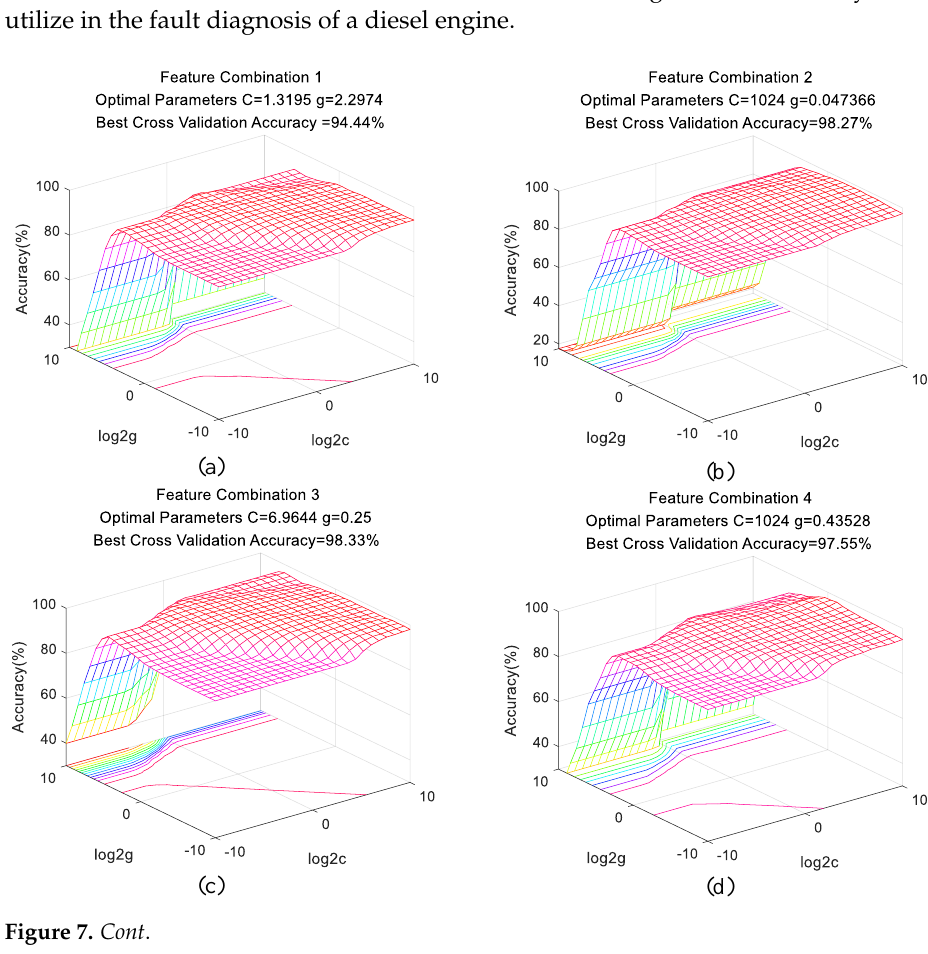
(h) Figure 7. The best optimization results of parameters C and g under different parameter character- istics: ( a ) Feature Combination 1; ( b ) Feature Combination 2; ( c ) Feature Combination 3; ( d ) Feature Combination 4; ( e ) Feature Combination 5; ( f ) Feature Combination 6; ( g ) Feature Combination 7; ( h ) Feature Combination 8.